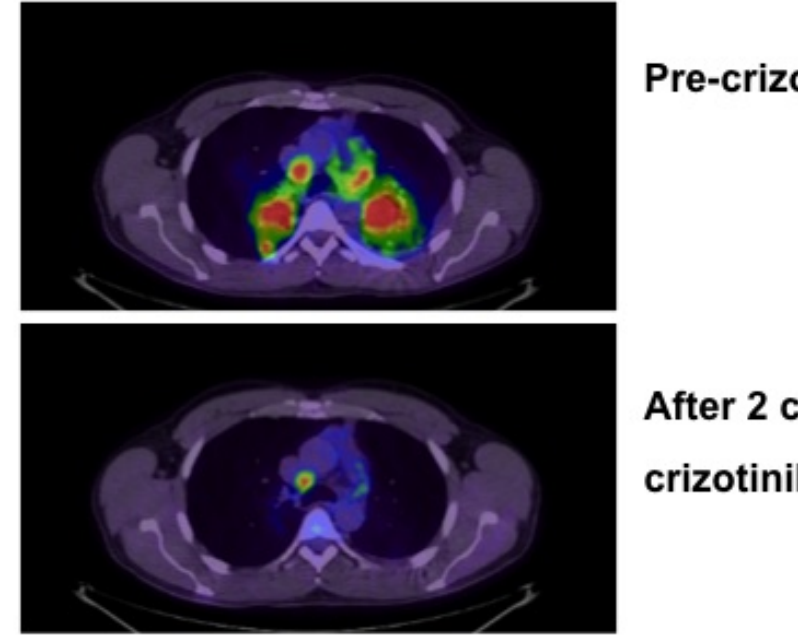
Figure 1. FDG PET/CT scans in a 43 y.o. male never smoker with anaplastic lymphoma kinase (ALK)-positive non-small cell lung cancer (NSCLC) prior to and after two cycles of